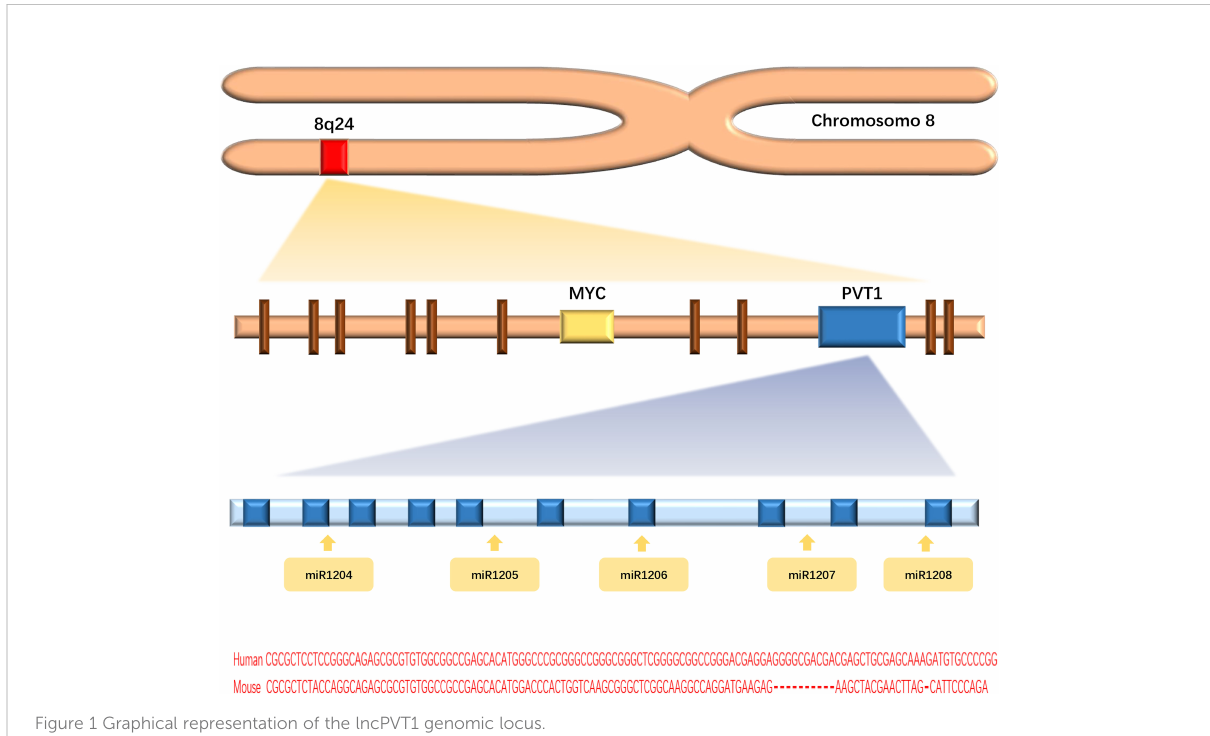
Figure 1 Graphical representation of the lncPVT1 genomic